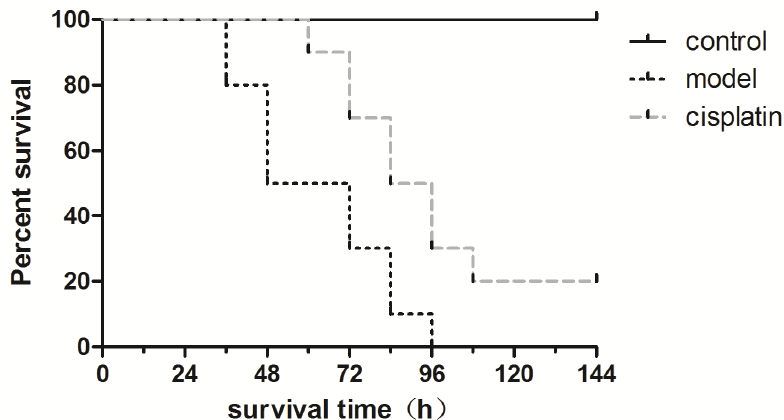
Figure 5. Effect of cisplatin on the survival time of